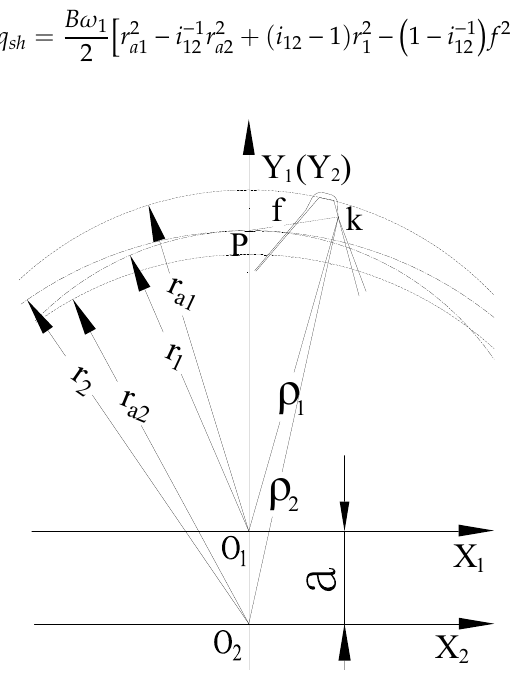
Figure 3. Meshing point’s position change.